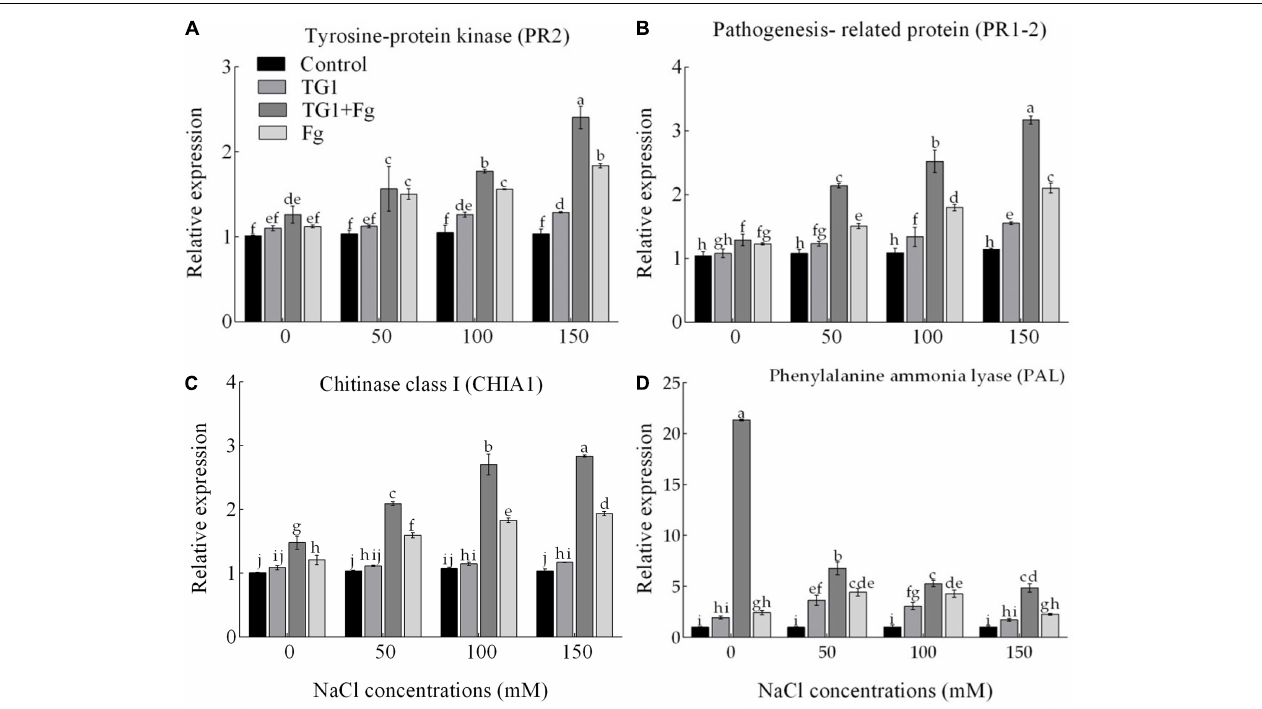
FIGURE 9 | Effect of T. longibrachiatum (TG1) on relative expressions of tyrosine-protein kinase PR2 (A) , pathogenesis-related protein PR 1-2 (B) , chitinase class I CHIA1 (C) , and phenylalanine ammonia-lyase (D) genes in the root of wheat seedlings under F. pseudograminearum (Fg) and different salinity stress at 28 days after inoculation. Small bars represent the standard errors of the means. Different lower case letters indicate significant differences at P < 0.05 in Duncan’s multiple range test using two-way ANOVA. Treatments are detailed in the footnote of Figure 5